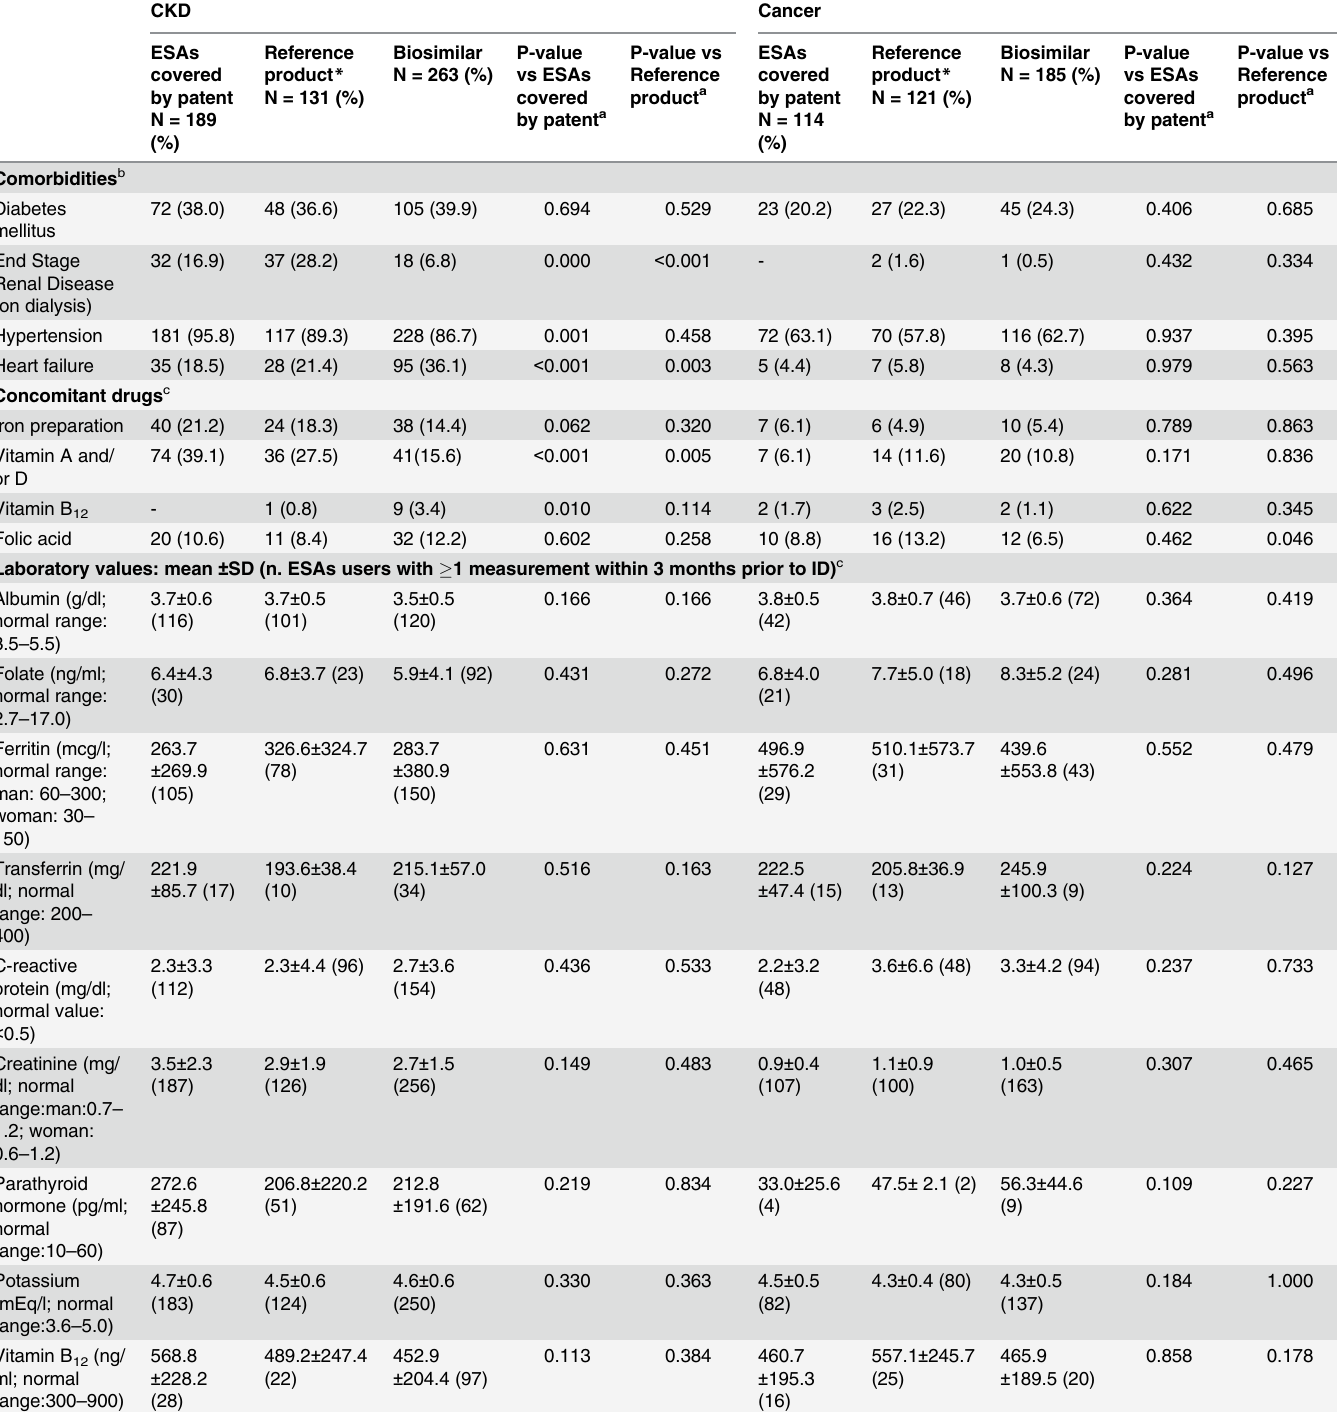
Table 2. Distribution of comorbidities, concomitant drugs and labotratory values of incident ESA users, stratified by indication for use and type of ESA. CKD Cancer ESAs